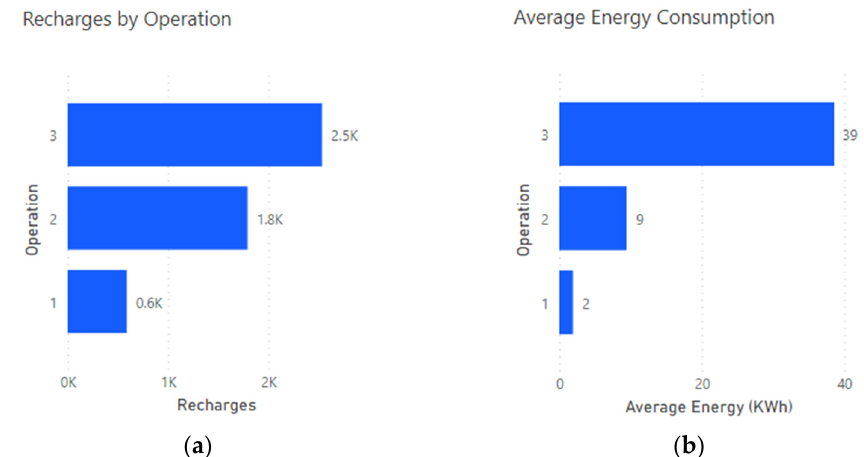
Figure 4. ( a ) Number of recharging sessions of each operation; ( b ) average energy consumption of each operation. each operation.